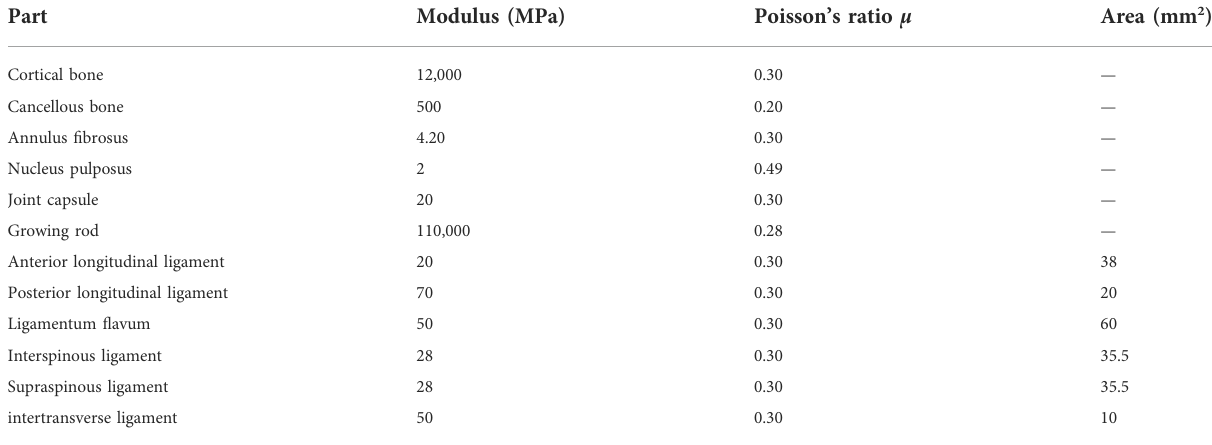
TABLE 1 Material properties of each part of the models.